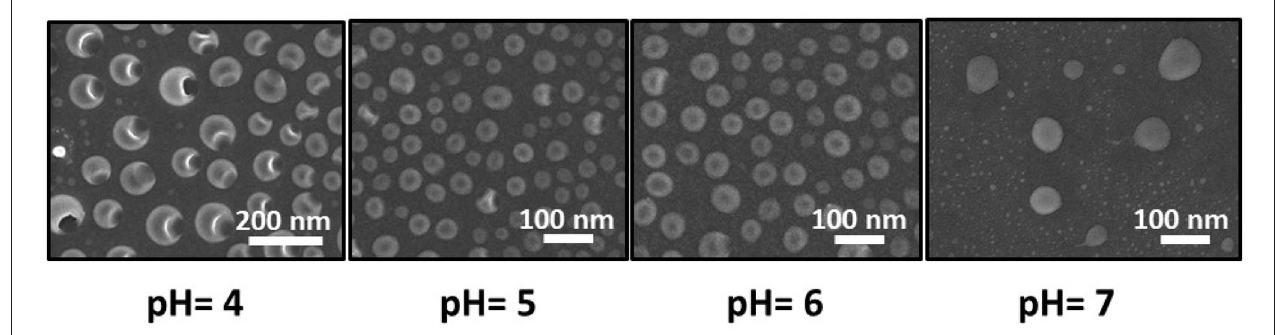
FIGURE 4 | Shape change of the vesicles in different pH. Porous vesicles were observed at ∼ pH = 4.